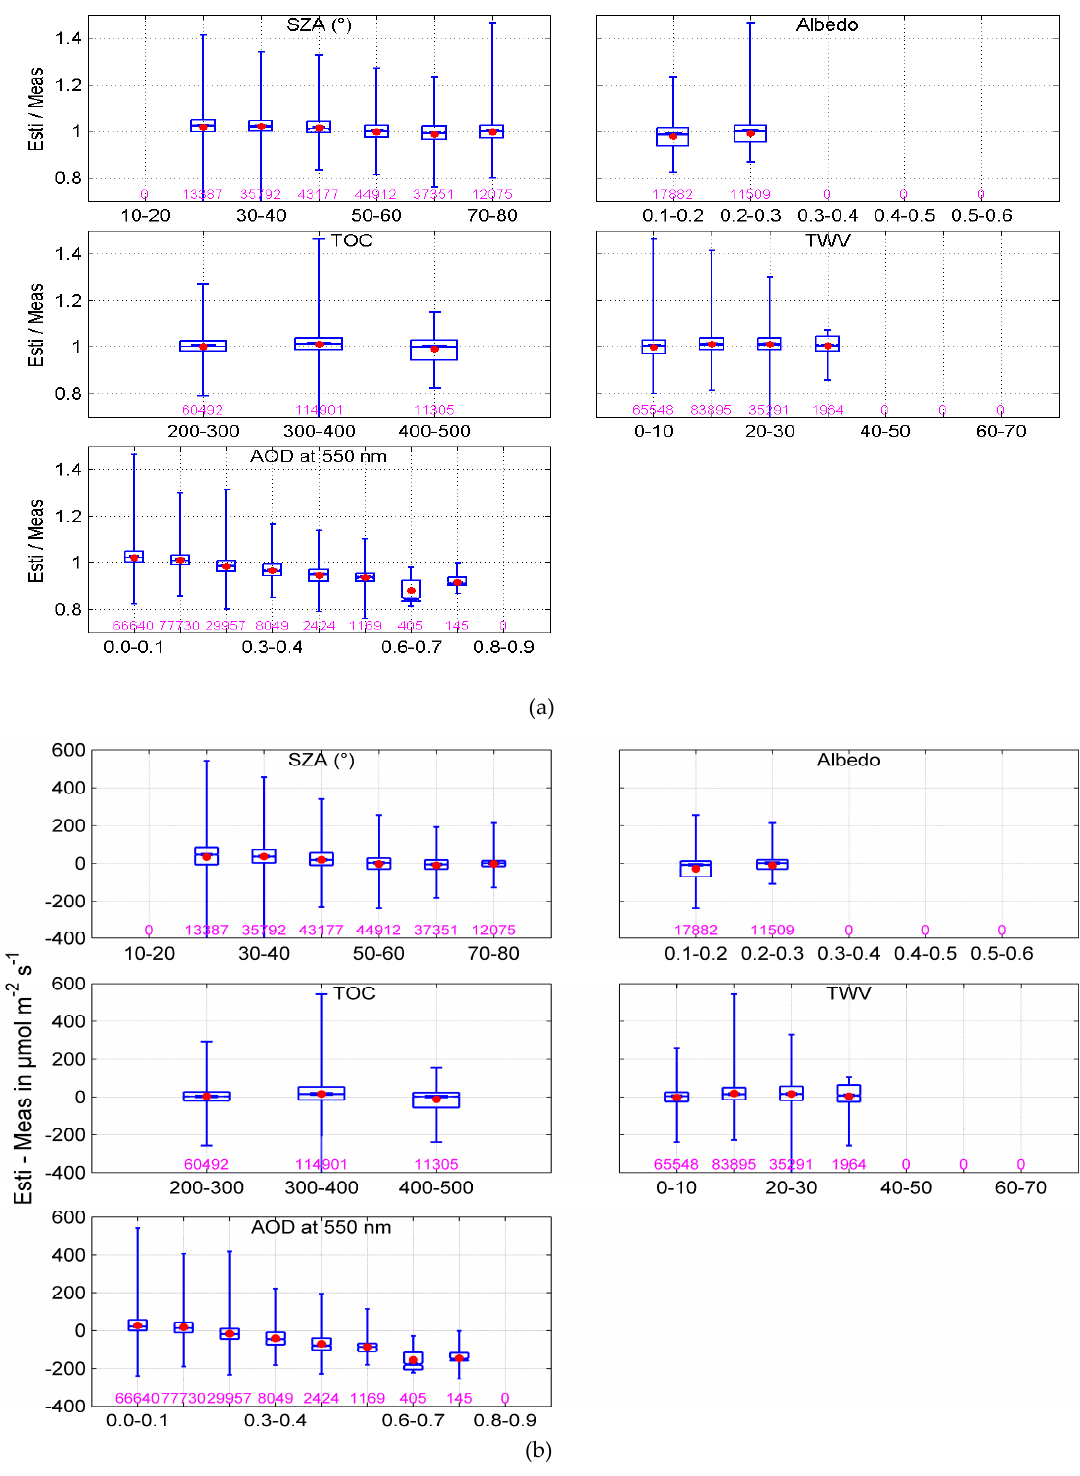
Figure 3. Change in ratio (estimate / measurement) ( a ) and deviation (estimate-measurement) ( b ) as a function of the solar zenith angle (SZA), albedo, total ozone column (TOC), total water vapor (TWV) and aerosol optical depth (AOD) at Fort Peck. Red dots indicate the mean. The limits of the boxes give the 1st, 2nd, and 3rd quartiles, while the extreme whiskers are the minimum and maximum. The numbers of pairs are given in pink.